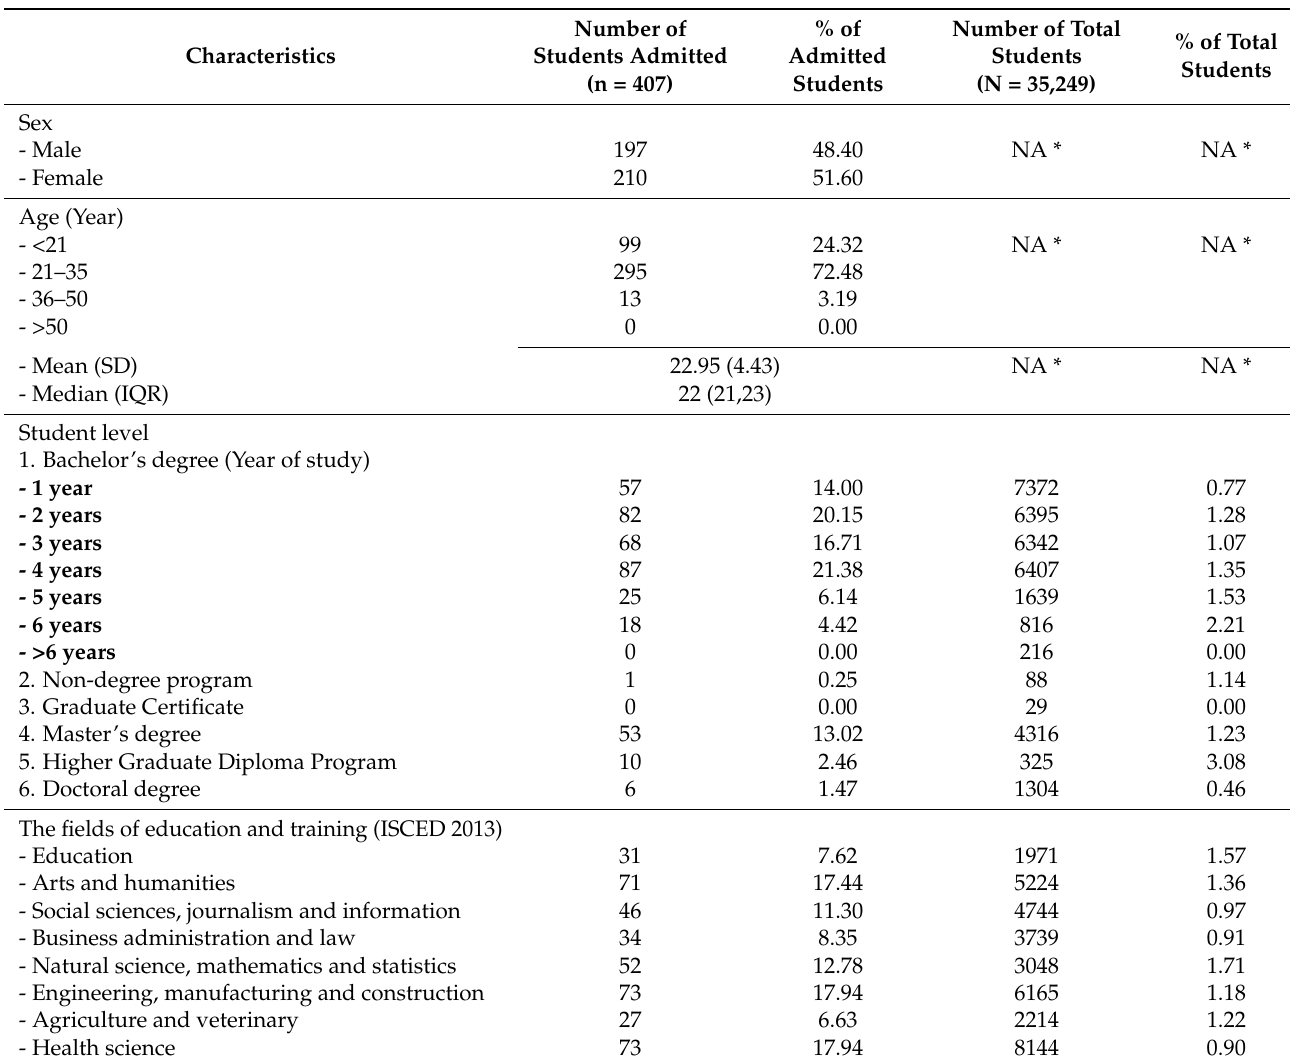
Table 4. Socio-demographic characteristics of CMU Students utilizing IPD service (n = 407